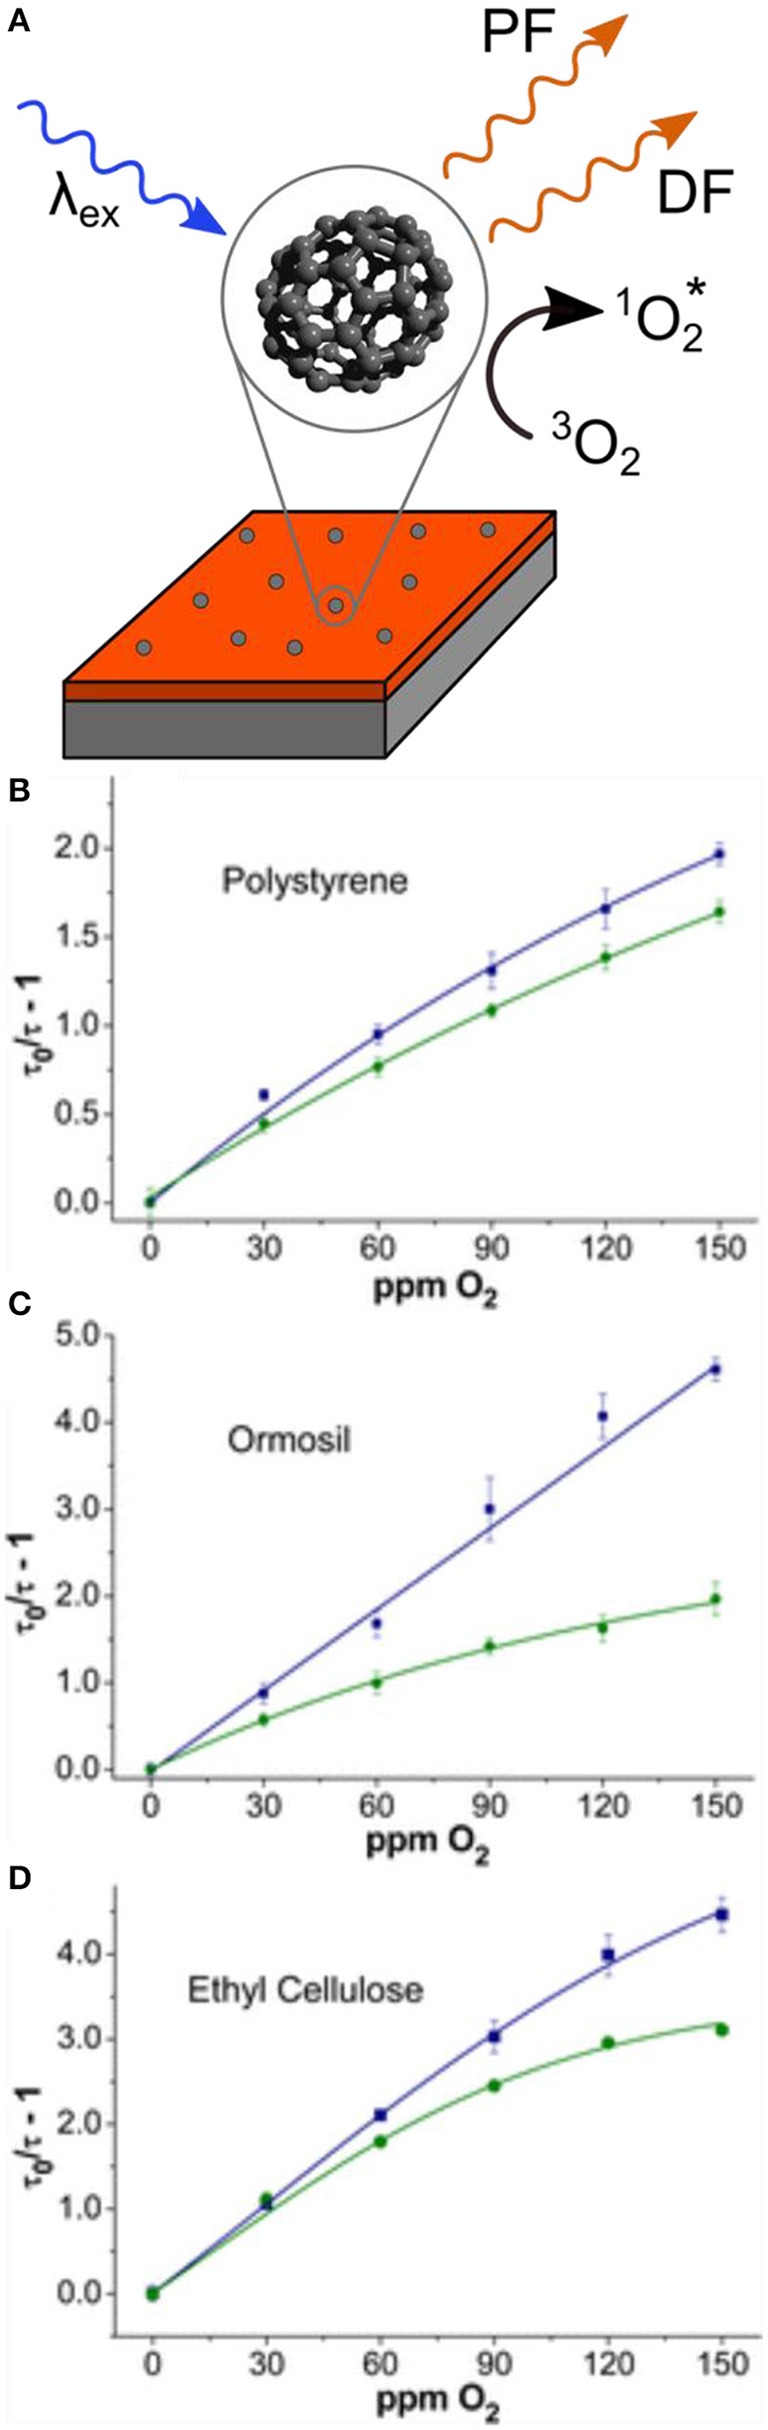
(A) Schematic representation of 13C70 films with excited state quenching by triplet oxygen; (B–D) lifetime-based Stern-Volmer plots at 298 K (blue squares) and 333 K (green circles) for 13C70 in (B) PS, (C) Ormosil, and (D) EC. Adapted from reference (Kochmann et al., 2013) with permission from the American Chemical Society.